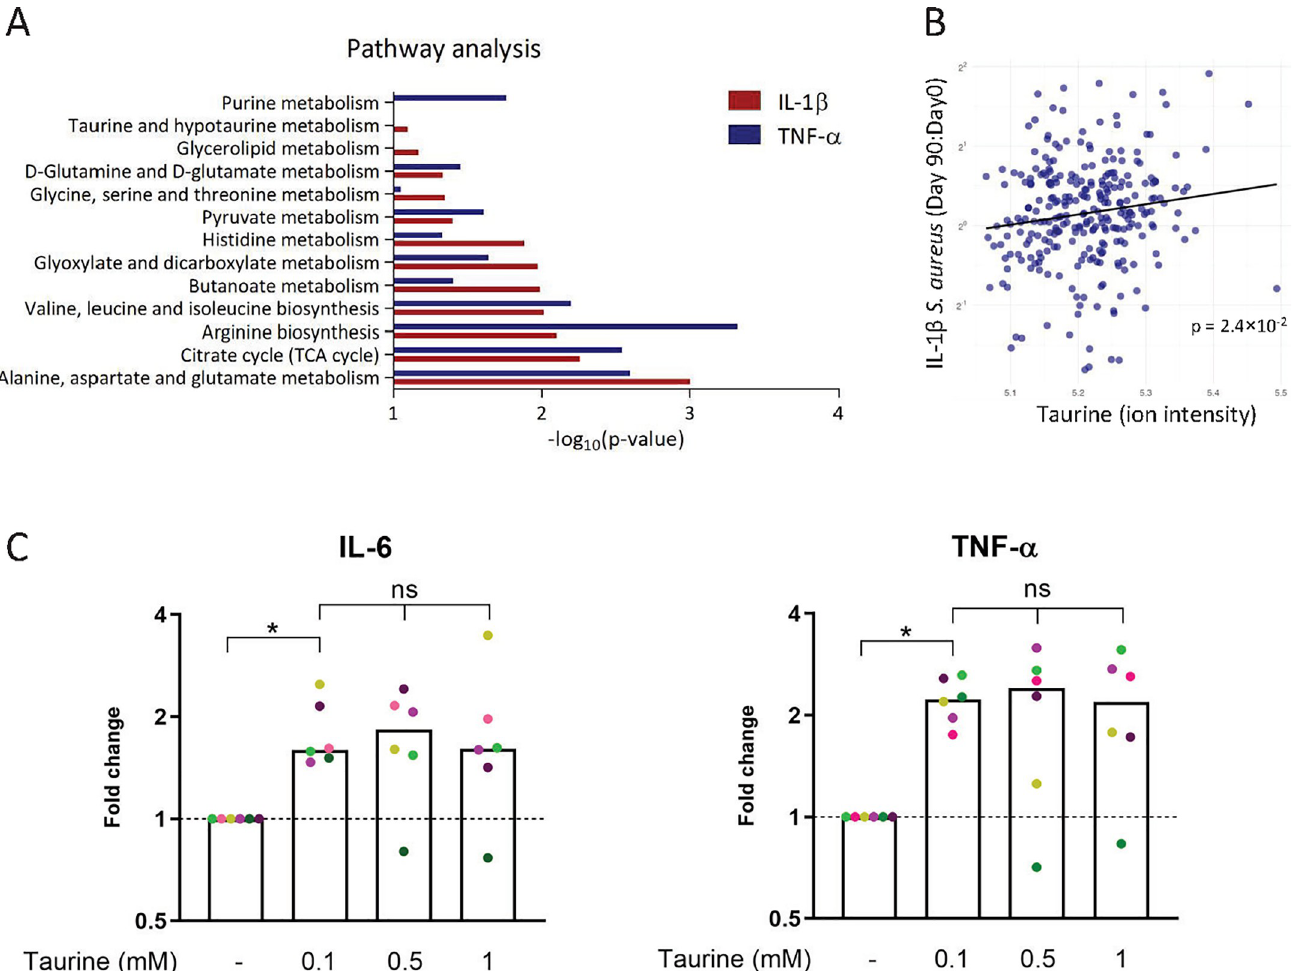
Fig 5. Pathway analysis of metabolites associated with trained immunity and the effect of taurine. ( A ) Pathway analysis of metabolites that are significantly ( p < 0.05) associated with the fold change in IL-1 β and TNF- α in response to S . aureus 3 months after BCG vaccination. Pathway analyses were performed using MetaboAnalyst (KEGG version October 2019) [19]. ( B ) Linear regression between taurine at baseline and fold changes of ex vivo PBMC-derived S . aureus -induced IL-1 β responses 3 months after vaccination. The metadata on study participants, metabolome, and cytokine data used to generate these figures are available at https://gitlab.com/xavier-lab-computation/public/bcg300. ( C ) Human primary monocytes were incubated for 24 hours with taurine (0.1, 0.5, or 1 mM), after which the medium was refreshed, and the cells were allowed to rest for 5 days, after which they were stimulated with E . coli LPS (10 ng/mL) for 24 hours. Then, the levels of IL-6 and TNF- α were measured, and a fold change was calculated relative to the medium control. The median values are presented, and each donor is represented in a different color ( N = 6, Wilcoxon matched-pairs signed rank test, ns = not significant, � p < 0.05). The cytokine values used to generate this figure can be found in S2 Data . BCG, Bacillus Calmette–Gue´rin; PBMC, peripheral blood mononuclear